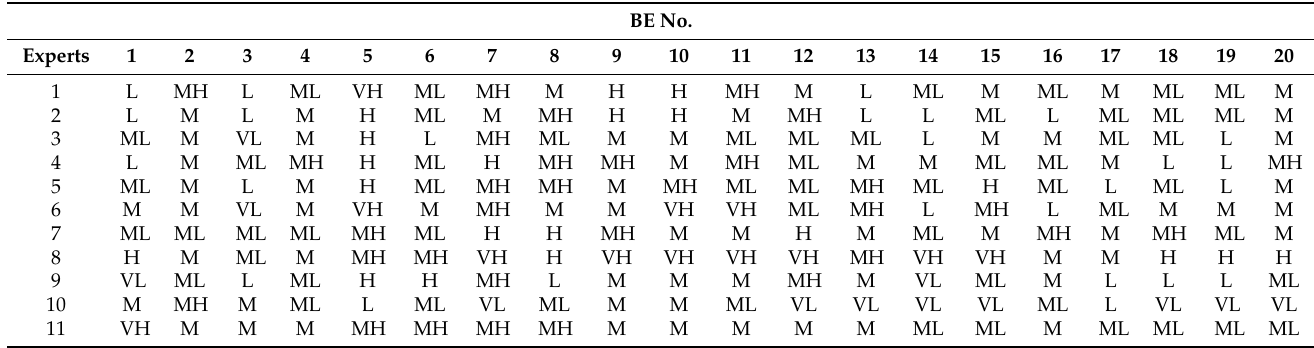
Table 5. Linguistic results of experts evaluations of BEs. BE